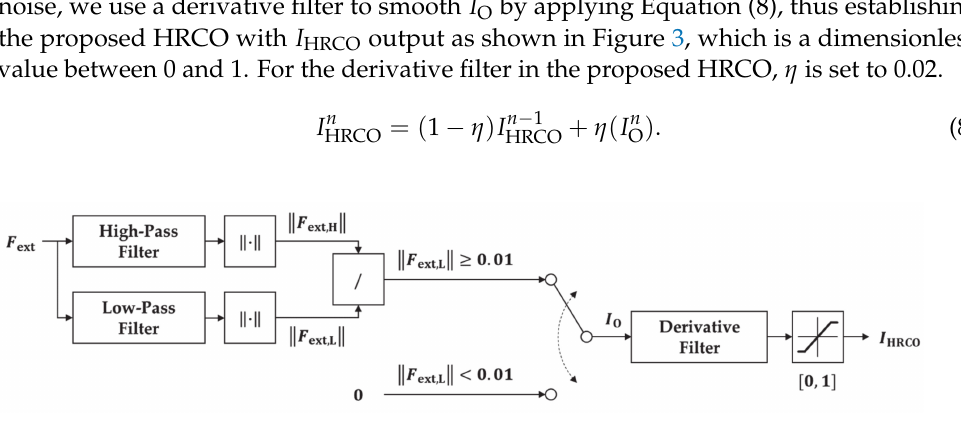
Figure 3. Block diagram of human–robot collaboration